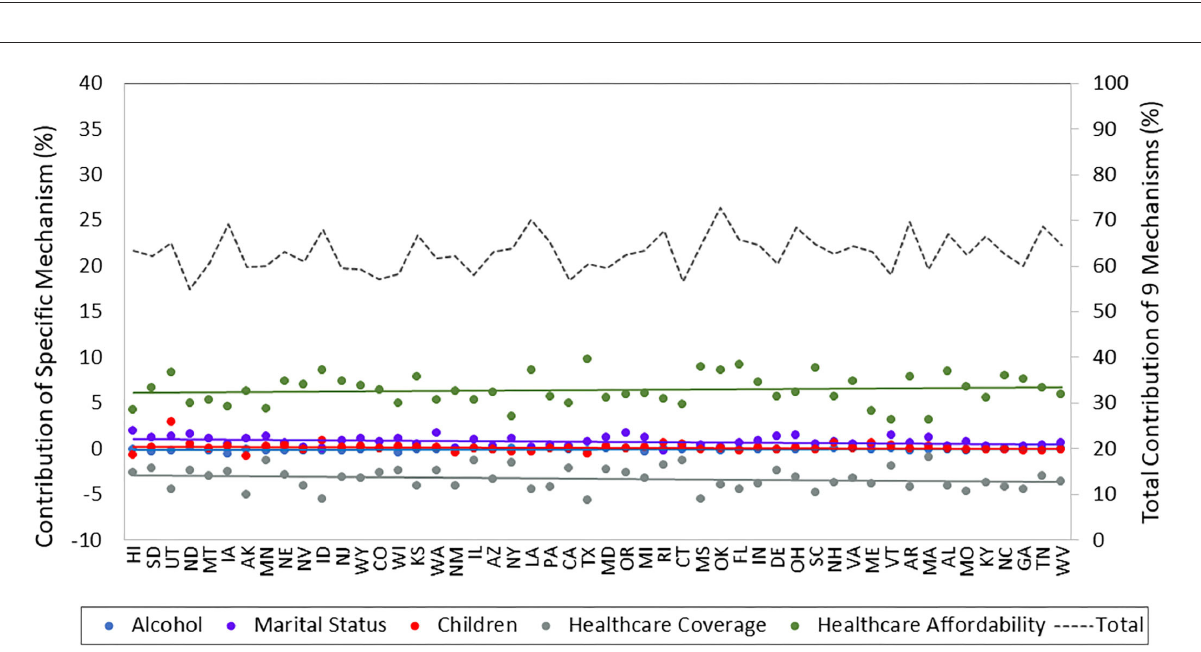
FIGURE3 Contribution of other mechanisms to the education-health association in U.S. states. Data are from the 2011–2018 BRFSS and include adults ages 25–64 years. States are ordered from left to right in ascending order of the strength of their education-health association.